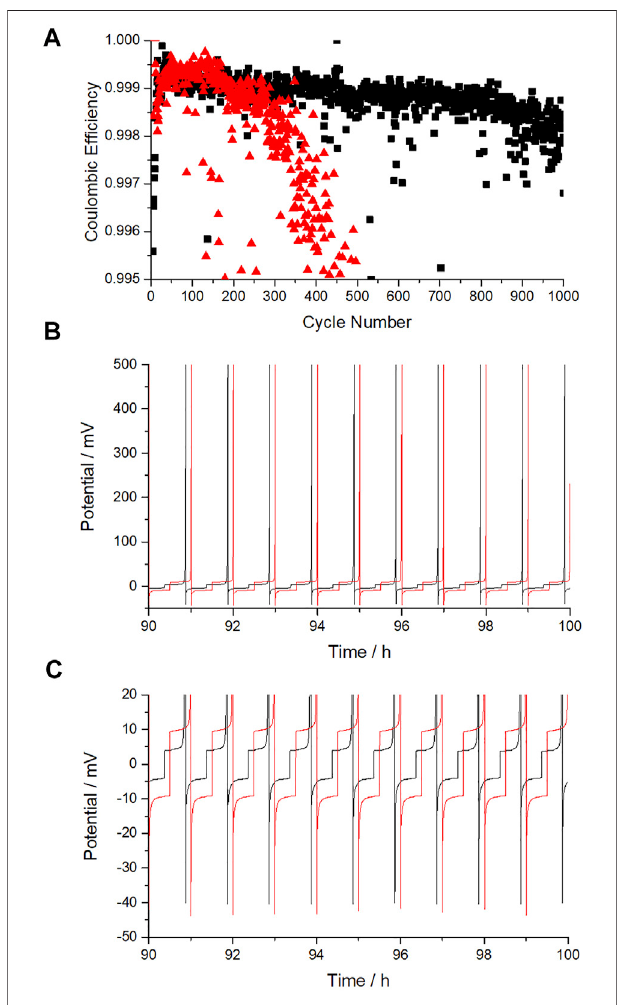
FIGURE 2 | (A) Coulombic ef fi ciency of Na||Cu cells cycled at two currentdensities incoincellformat,0.5and 0.2 mA cm − 2 30-mincycling(0.25 and 0.1 mAh cm − 2 ). (B) voltage-time at 90 – 100 h emphasizing the complete stripping of sodium. (C) voltage time graph focusing on the plating- stripping hysteresis and nucleation overpotential. 0.5 mA cm − 2 cycling is shown in red and 0.2 mA cm − 2 cycling in black.